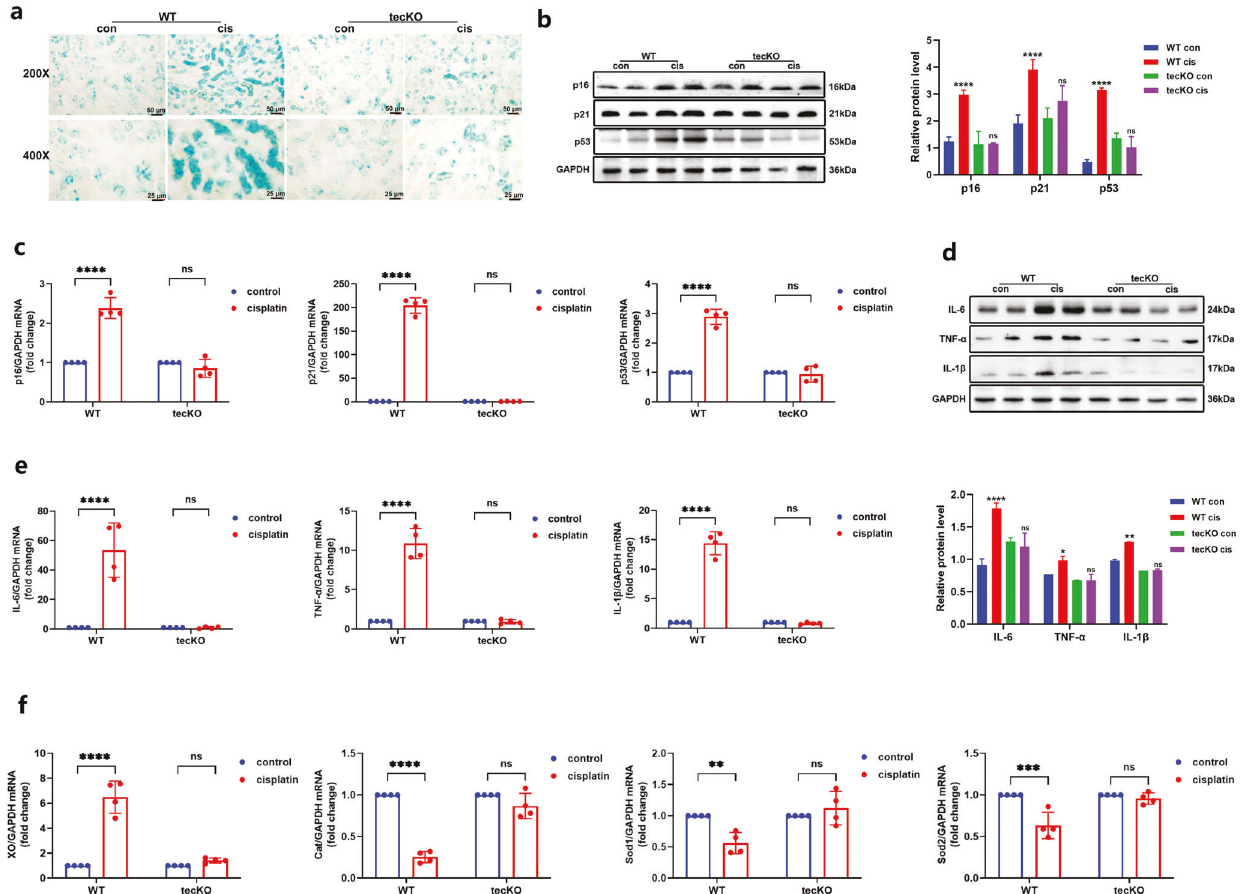
Fig. 4 Tubular AhR deletion improved cellular senescence and oxidative stress in cisplatin-induced AKI mice. a Representative images of SA- β -Gal staining in cisplatin-induced WT and AhR tecKO mice (magni fi cation ×200 and ×400). Blue: SA- β -Gal positive region. b Protein expression of SAGs (p16, p21, p53) and d SASPs (IL-1 β , IL-6, TNF- α ) shown by western blot in WT and AhR tecKO mice with or without cisplatin administration, and the relative protein level was quanti fi ed by densitometry and normalized with GAPDH ( n = 3); **** P < 0.0001, ** P < 0.01, * P < 0.05 compared with WT control group; ns P > 0.05 compared with tecKO control group. All western blot protein samples were taken from two random mice in different group, and the experiments were repeated three times. c Transcript expression of SAGs (p16, p21, p53) and e SASPs (IL-1 β , IL-6, TNF- α ) in WT and AhR tecKO mice with or without cisplatin administration ( n = 4). f Oxidant (XO) and anti-oxidant (Cat, Sod1, Sod2) expression, measured by RT-qPCR in WT and AhR tecKO mice with or without cisplatin administration ( n = 4). Data are represented as means ± SDs. cis, cisplatin. **** P < 0.0001, *** P < 0.001, ** p < 0.01, ns P >